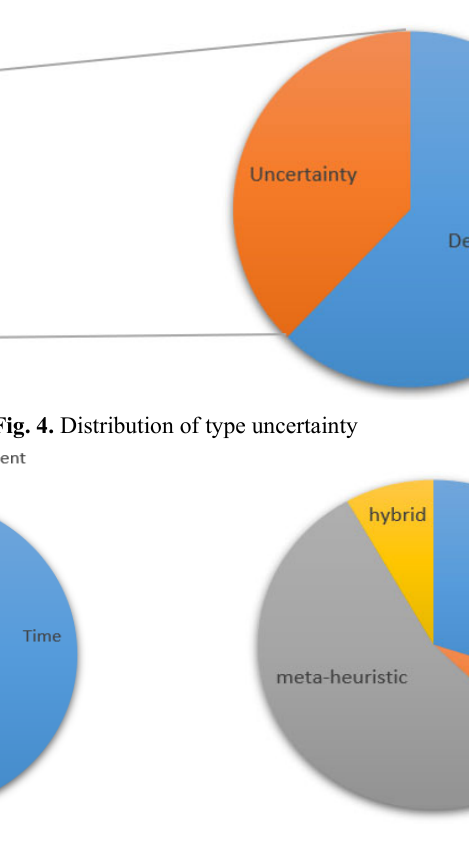
Fig. 6. Distribution of solution methods Fig. 5. Distribution of uncertainty